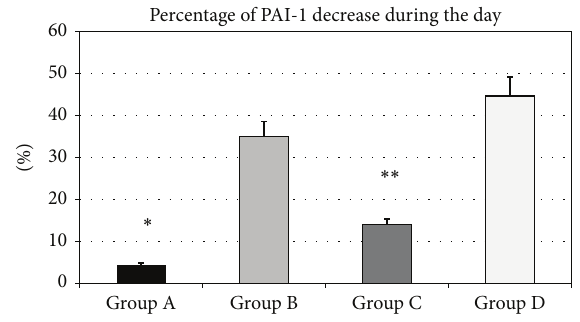
Figure 2: The percentage of PAI-1 decrease during the day, from 08:00 to 18:00, in T2D patients with CAD (group A), T2D without CAD (group B), nondiabetics with CAD (group C), and healthy controls (group D). 𝑃 values indicate the statistical significance of the difference across the groups, as estimated by ANOVA with post hoc Bonferroni test. Data are means ±